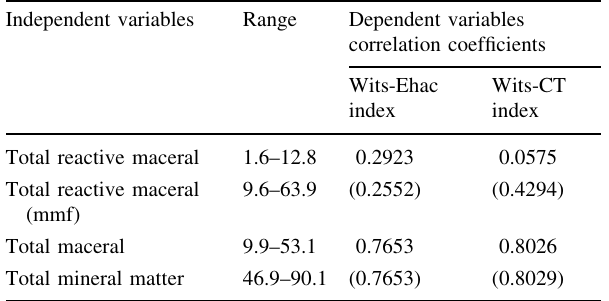
Table 7 Relationships between independent (total reactive maceral, total maceral and total mineral matter vol%) and dependent variables for coal-shale samples